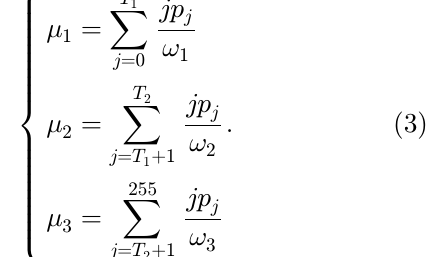
Fig. 1. S component and B component images and corre- sponding